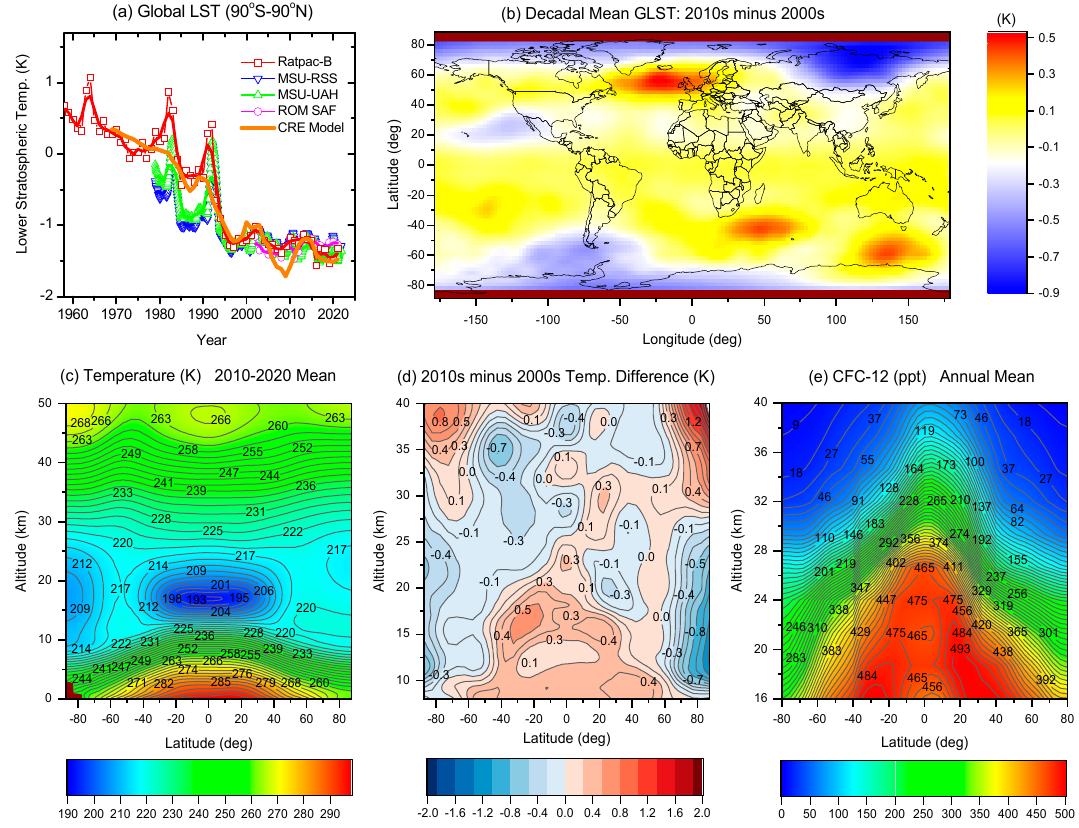
Figure 1. ( a ): Time-series annual mean lower-stratospheric temperature anomaly datasets of the global (90° S–90° N) since 1958, obtained from multiple ground- and satellite-based data measure- ments (Ratpac, MSU-UAH, MSU-RSS and ROM SAF), as well as temperatures calculated by the CRE equation (thick solid lines in orange, see text). Further, also shown are the 3-year smoothing (thick solid lines in colors) to observed temperature anomalies (symbols). Note that for comparisons, the lower-stratospheric temperature anomalies are offset to the same level in the 2000s–2010s, but this offsetting has no effects on their long-term trends. ( b ): Map for the decadal mean global lower- stratospheric temperature (GLST) difference of the 2010s (2010–2020) minus the 2000s (2000–2010). ( c ): Decadal mean zonal mean latitude–altitude distribution of the temperature climatology in the